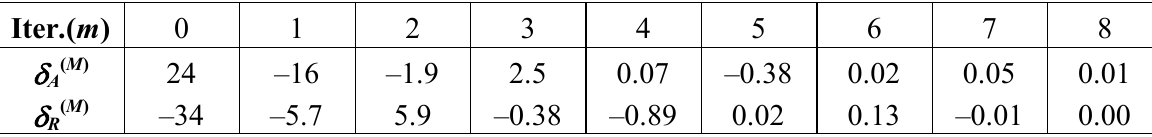
Table 2. Relative errors of measurement on f = 500 kHz with iterating correction.